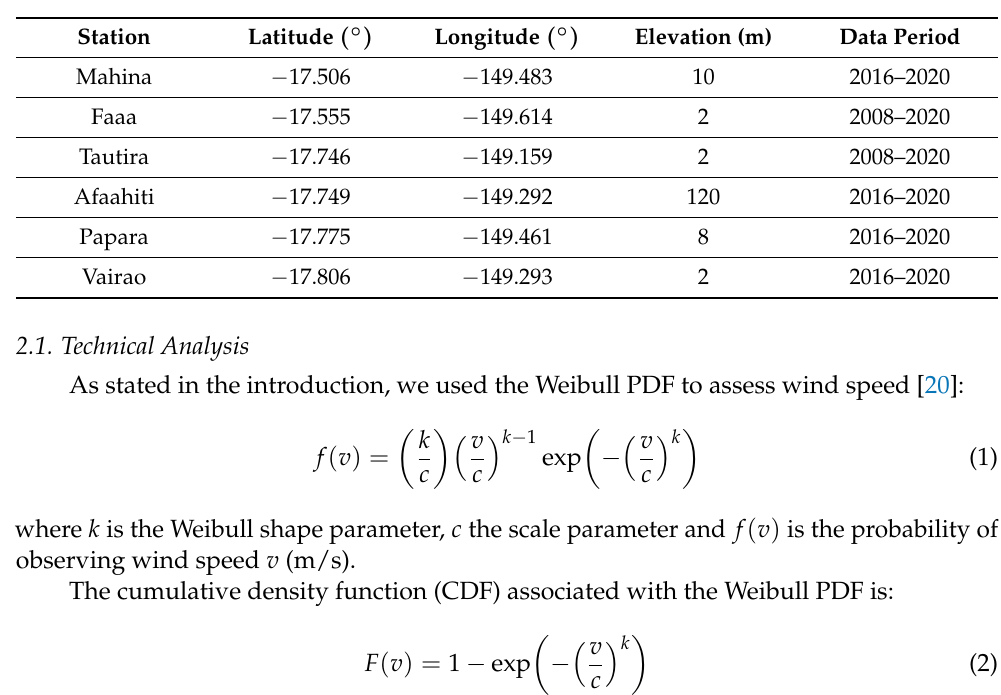
Figure 1. Map of Tahiti showing the locations of the six wind sensors. Table 1. Details regarding the locations of the wind